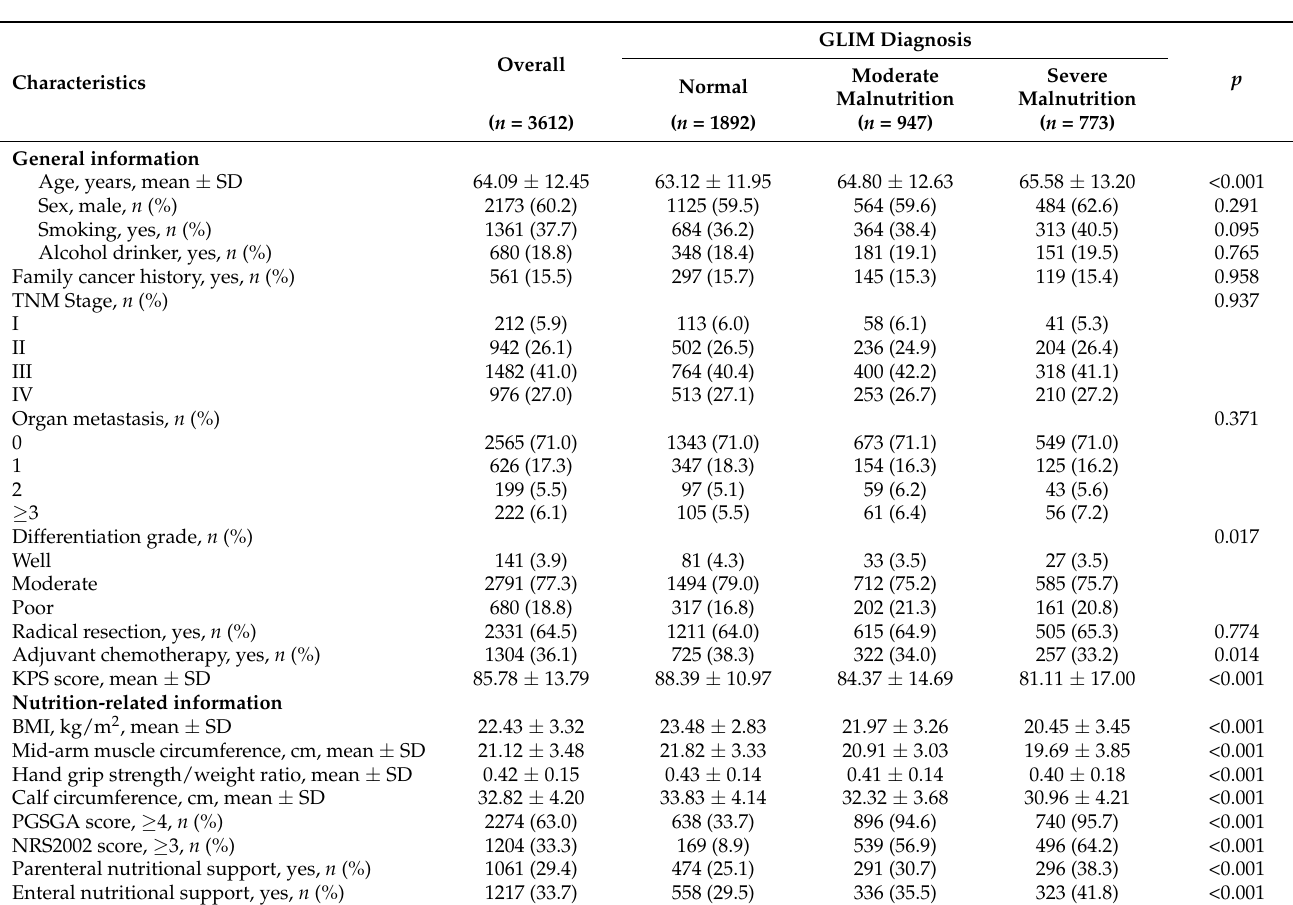
Table 4. Baseline Characteristics of the development